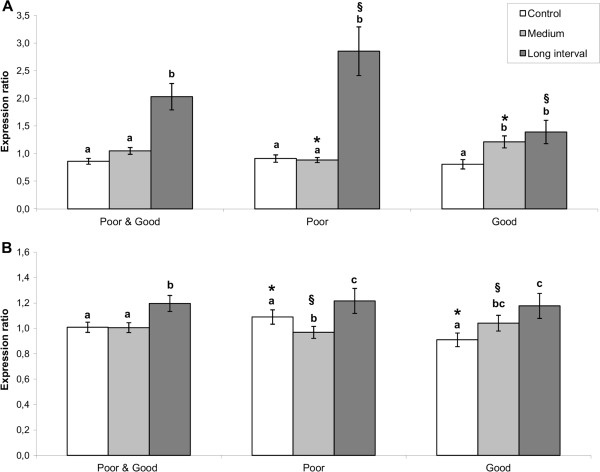
Expression of virus-responsive genes in tissues of exercised and swim performance groups post IPN challenge. Improved survival after IPN challenge was associated with the expression of virus responsive genes (VRGs) as assessed by qPCR. Higher expression levels of VRGs in cardiac tissue of poor compared to good swimmers from the Lint regime (A), and in head kidney of poor compared to good swimmers from the control group (B) reflected the overall higher mortality of poor swimmers in comparison to the good swimmers. Further, VRGs expression in both tissues was in concordance with differences in survival between interval (Lint) and constant speed (Control and Medium) training regimes. Bars represent expression ratio ± SEM relative to a pooled control sample and normalized against two reference genes (18S rRNA and elongation factor 1α) with correction for PCR efficiency. For A and B, each bar is a composed index of 6 (n = 8 fish/swim-performance/regime) and 8 (n = 5 fish/swim-performance/regime) VRGs, respectively. Genes included: RSAD2 (radical S-adenosyl methionine domain containing protein2) (A + B), IFIT5 (interferon-induced protein with tetratricopeptide repeats 5) (A + B), STAT1 (signal transducer and activator of transcription 1) (A + B), VHSV2 (viral haemorrhagic septicaemia virus-inducible protein) (A + B), BAF (barrier-to-autointegration factor) (A + B), GIG1 (interferon-inducible Gig1) (A + B), RIG-I (DEAD/H (Asp-Glu-Ala-Asp/His) box polypeptide) (B), MDA5 (interferon induced with helicase C domain 1) (B). abc: Denotes significant difference (p < 0.05; paired t-test) between training regimes. Other symbols (*§) denotes significant difference (p < 0.05; paired t-test) between poor and good swimmers within each training regime.